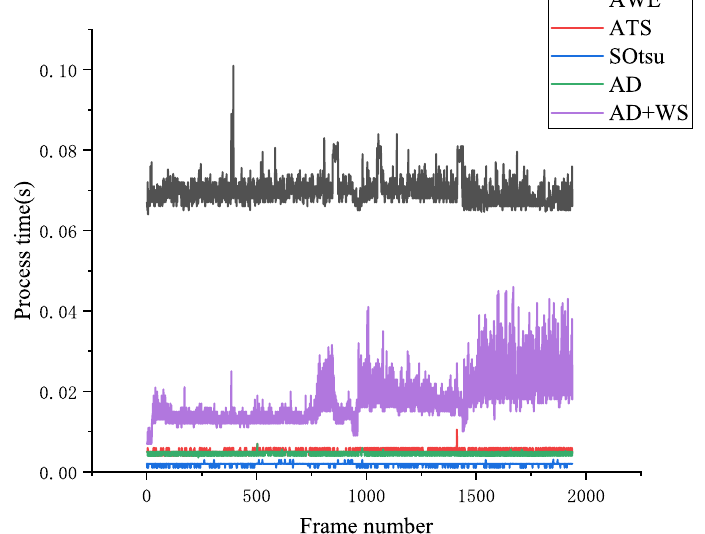
Figure 19. Comparison of processing time of different methods. Note: AD, proposed abnormal detection method; AD+WS, proposed abnormal detection method + proposed whitecap separation method; SOtsu, sub-image Otsu